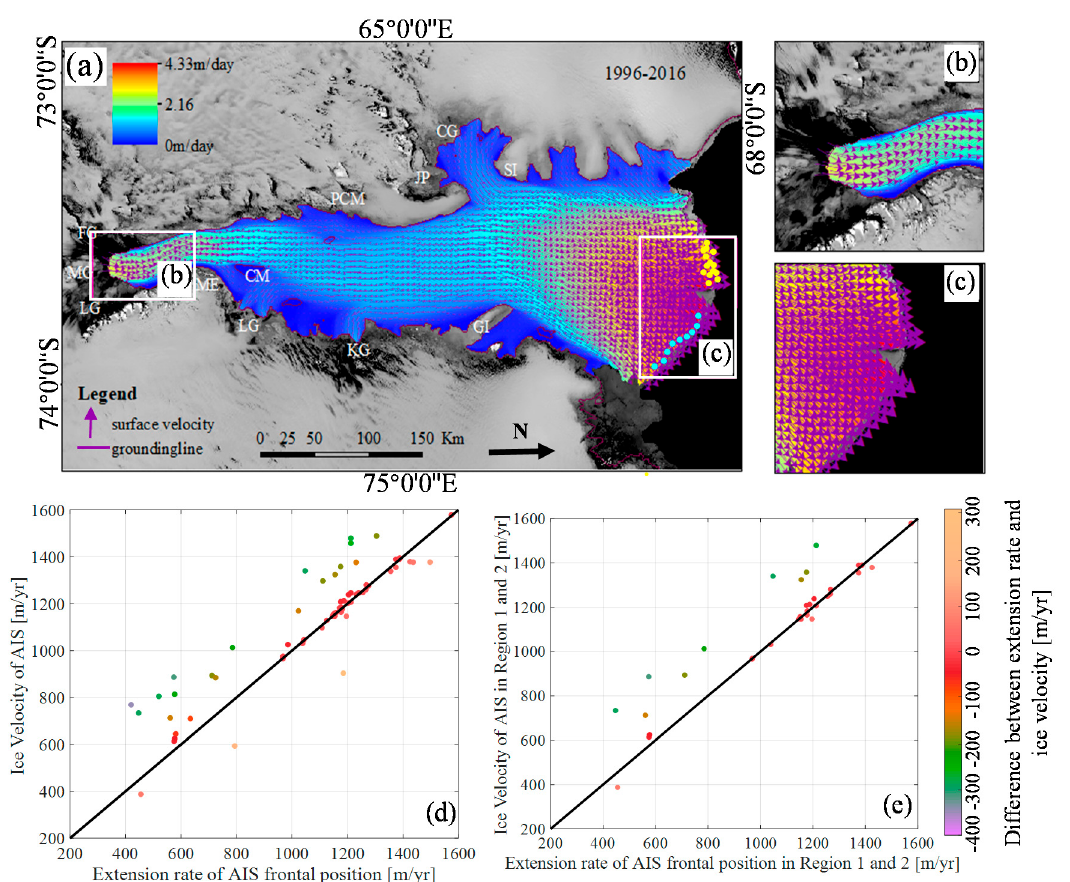
Figure 10. Correlation analysis between the frontal extension rate of the AIS and the MEaSUREs ice velocity product. The relation of ice velocity and the extension rate using the scatter plot by the extension rate and MEaSUREs ice velocity products. ( a ) MEaSURE ice velocity product; ( b ) ice velocity at the intersection of Lambert Glacier (LG), Fisher Glacier (FG), and Mrellor Glacier (MG); ( c ) ice velocity in the front of AIS; ( d ) scatter plot of the extension rate in the front of AIS and MEaSUREs ice velocity product(yellow and light blue points); ( e ) scatter plot of the extended distance at the frontal position of the D28 disintegration area and MEaSUREs ice velocity product (yellow points).